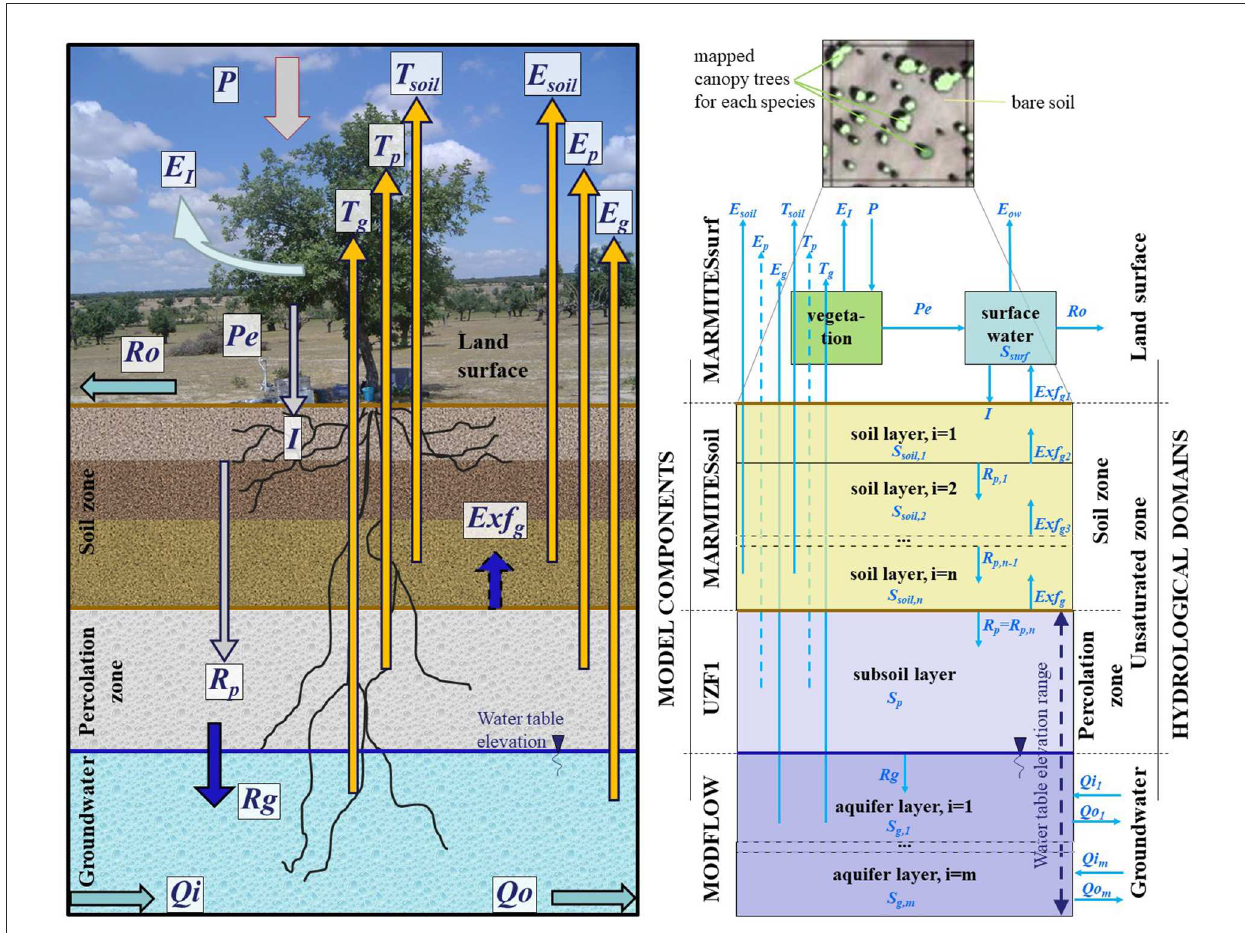
FIGURE2 Conceptual schema of the coupled MARMITES-MODFLOW model, showing the water flux components and the partitioning and sourcing concept. (Left) General scheme describing the exchange of water fluxes between hydrological domains. (Right) Structure of one vertical cell showing the exchange of water fluxes. P , precipitation; E I , interception; Pe , effective precipitation; E ow , open water body evaporation; Ro , surface runoff; S surf , land surface storage; I , infiltration; E soil , soil evaporation; T soil , soil transpiration; S soil , soil zone storage; n , number of soil layers; Exf g , groundwater exfiltration into soil zone; R p , percolation from the soil zone; E p , evaporation from percolation zone; T p , transpiration from percolation zone; S p , percolation zone storage; R g , gross recharge; E g , groundwater evaporation; T g , groundwater transpiration; S g , groundwater storage; Qi/Qo , lateral groundwater inflow/outflow; m , number of aquifer layers. Note that both E p and T p are considered negligible and are not computed (indicated with dash